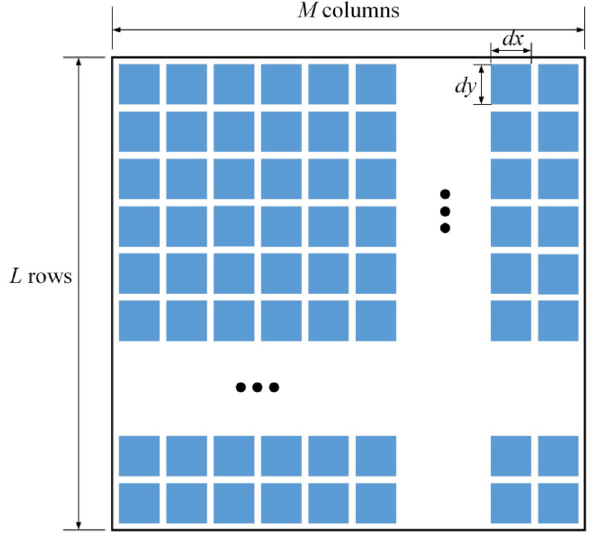
Figure 1. The schematic diagram of IRS